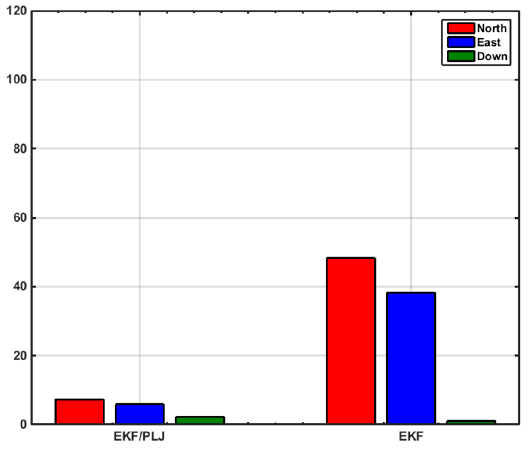
Figure 18. RMS Positions Errors—Scenario #2.